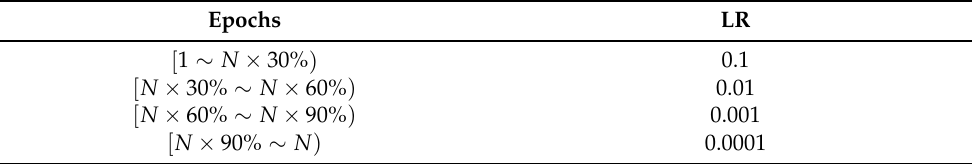
Table 1. The relationship between the LR and the number of